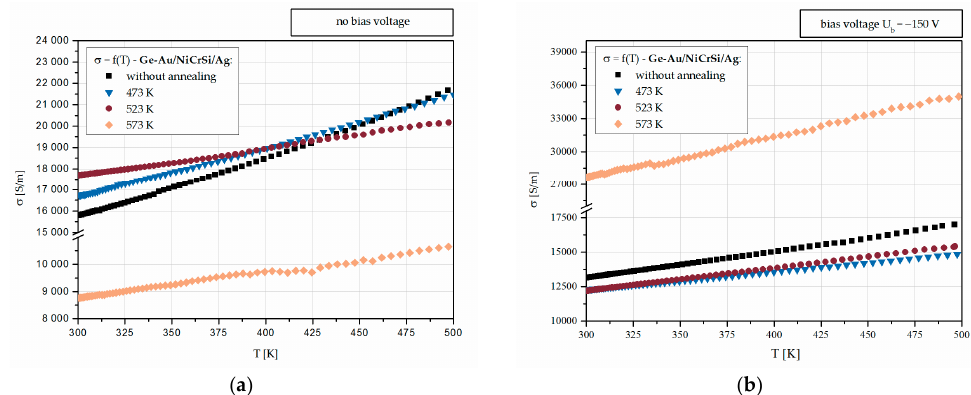
Figure 4. The resistance R as a function of the structure’s temperature T before and after annealing: ( a ) Ge–Au/NiCrSi/Ag test structures deposited in the sputtering process without external bias voltage; ( b ) Ge–Au/NiCrSi/Ag test structures deposited in the sputtering process with external bias voltage.